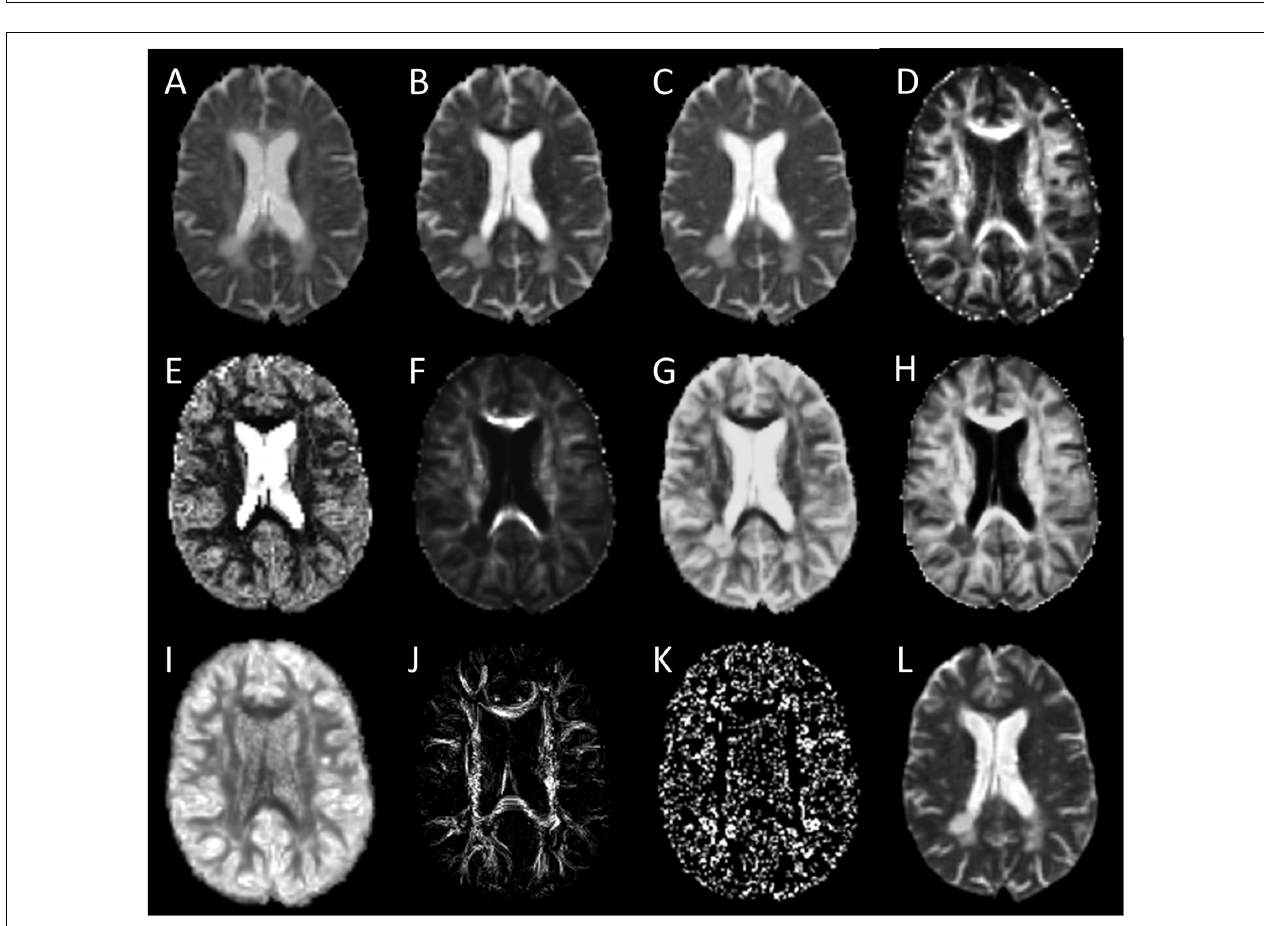
FIGURE 2 | Sample diffusion metrics based on DTI, ssHARDI, and DTI tractography models. Shown are measures from DTI: (A) axial diffusivity, (B) radial diffusivity, (C) mean diffusivity, and (D) fractional anisotropy; ssHARDI: (E) orientation dispersion index, (F) density, (G) diameter, (H) intracellular volume fraction, and (I) orientation distribution function (ODF) energy; and DTI tractography: (J) fiber density index and (K) fiber termination index. Shown in (L) is an example b0 image from DTI for reference.